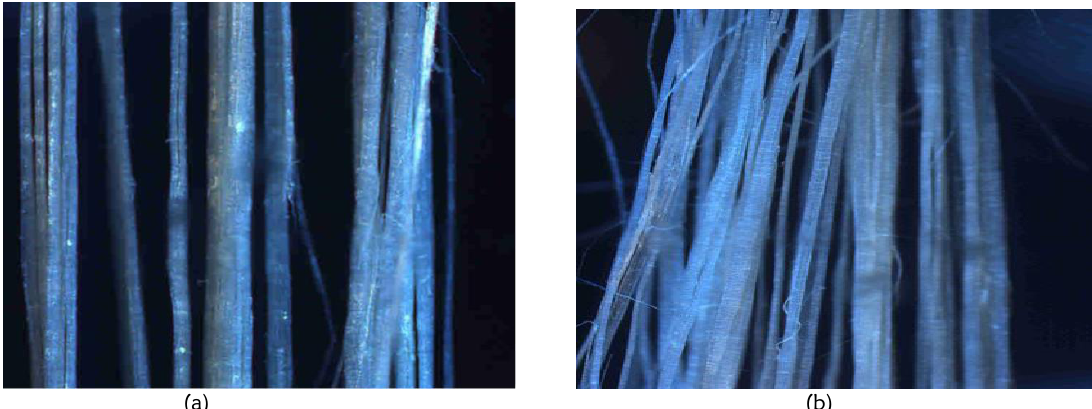
Figure 2: The Surface image of (a) untreated OF and (b), mercerized OF